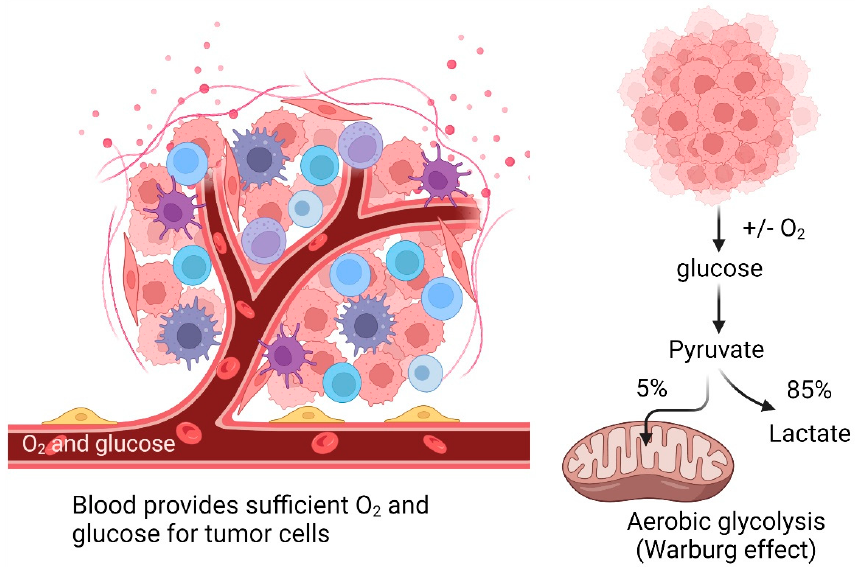
Figure 3. The Warburg effect in cancer.